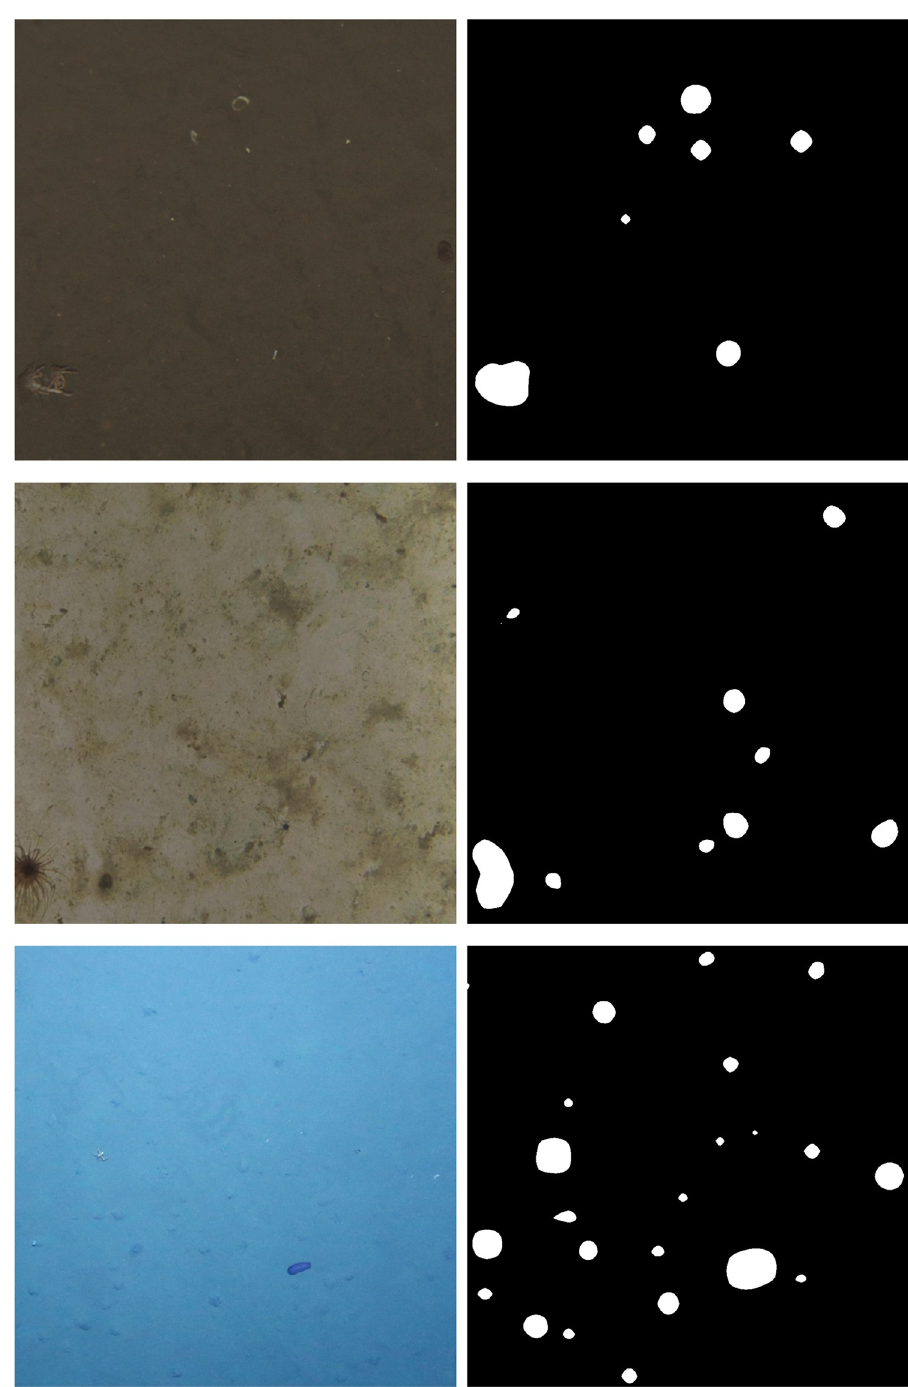
Fig 4. Crops of example images I (left column) and their thresholded novelty maps N i three image datasets JC77 (top row), PAP (middle row) and SO242 (bottom row).